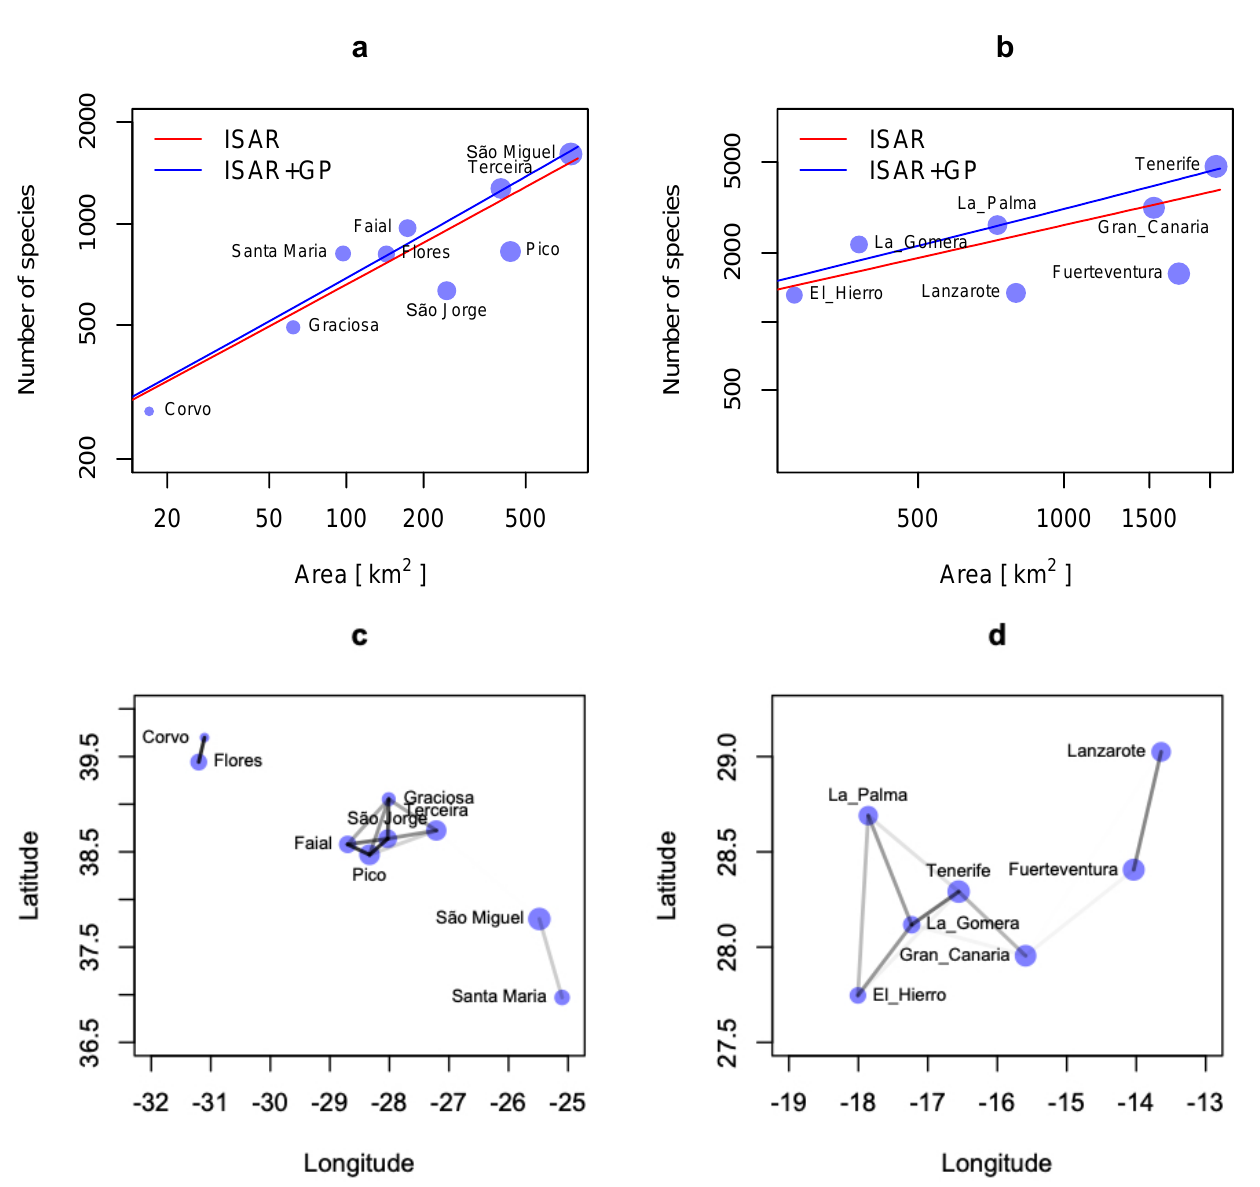
Figure 2. Plots ( a , b ) show the fitting with the Gaussian process, GP, (blue line) and without (red line) for the island species–area relationship (ISAR) model. The shadow areas correspond to 95% credible intervals. The fitting lines were obtained with the mean values of the posterior of the parameters c and z of S = cA z . For the model with the Gaussian process, the fitting line corresponds only to S = cA z , i.e., without the Gaussian process term. Plots ( c , d ) are geographical locations of the archipelagos and the darkness of the lines among the islands represents the strength of the correlations (for some pairs of islands, the correlation value is so small that the line is not visible). The size of the dots is proportional to the area of the